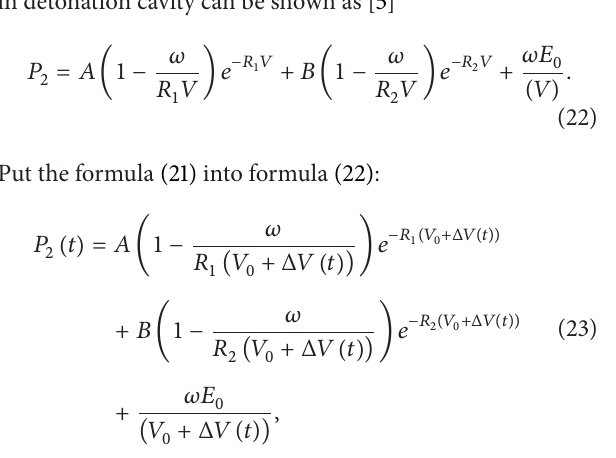
where 𝑟(𝑡) is the blast hole radius with time, 𝑢(𝑡) is the expansion velocity of blast hole wall, 𝜔(𝜂) is the width of fracture, and 𝑦(𝑡) is displacement of filling with